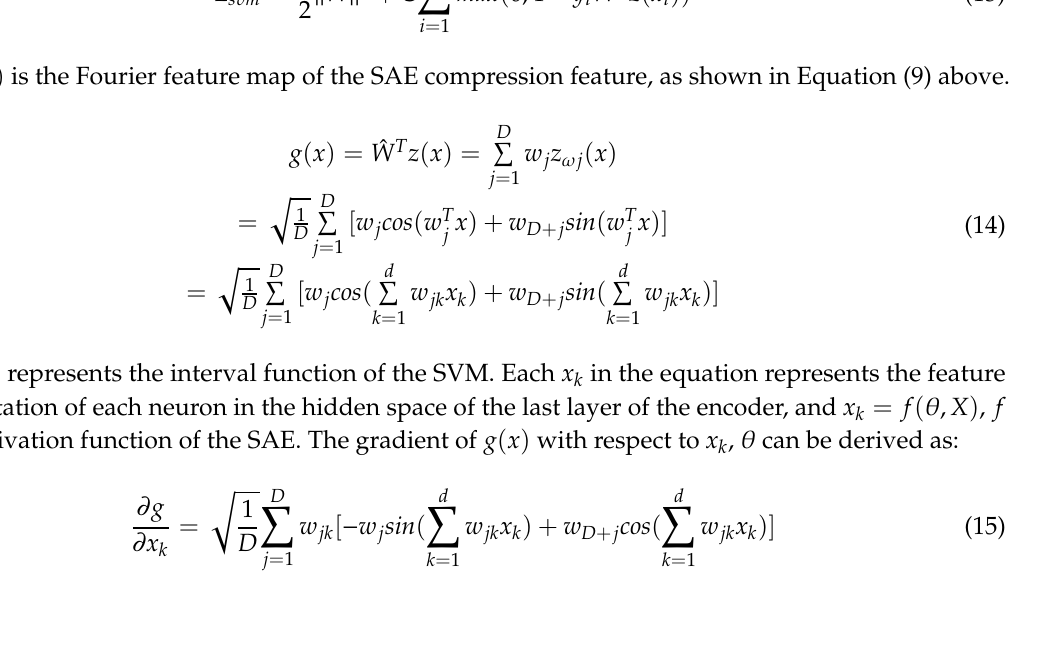
Figure 4. Proposed joint training model.